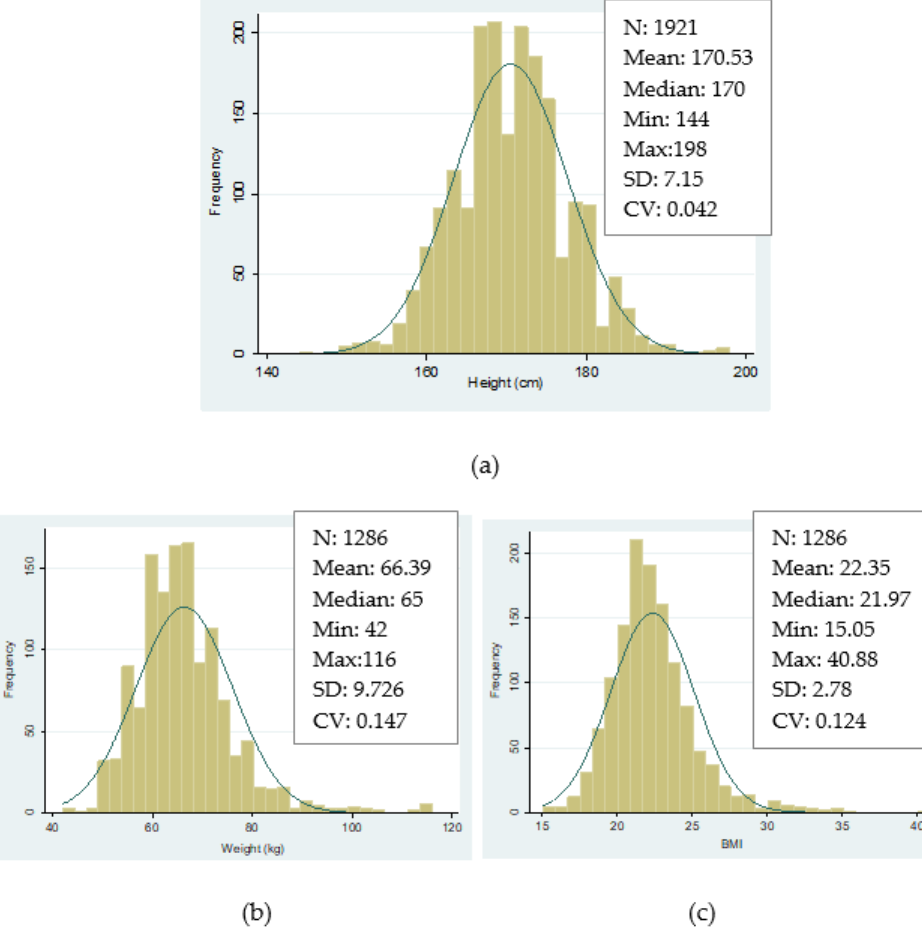
Figure 4. Histograms. ( a ) Height distributions in SB, birth cohorts 1886–1982. ( b ) Weight distributions in SB, birth cohorts 1886–1982. ( c ) Body mass index in SB, birth cohorts 1886–1982. Source: AMSB, ACDS. Own work.